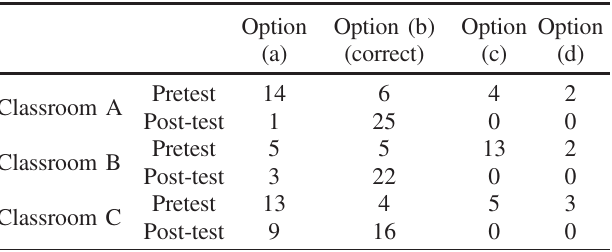
TABLE III. Students ’ answers to question Q4 for both pretests and post-tests.